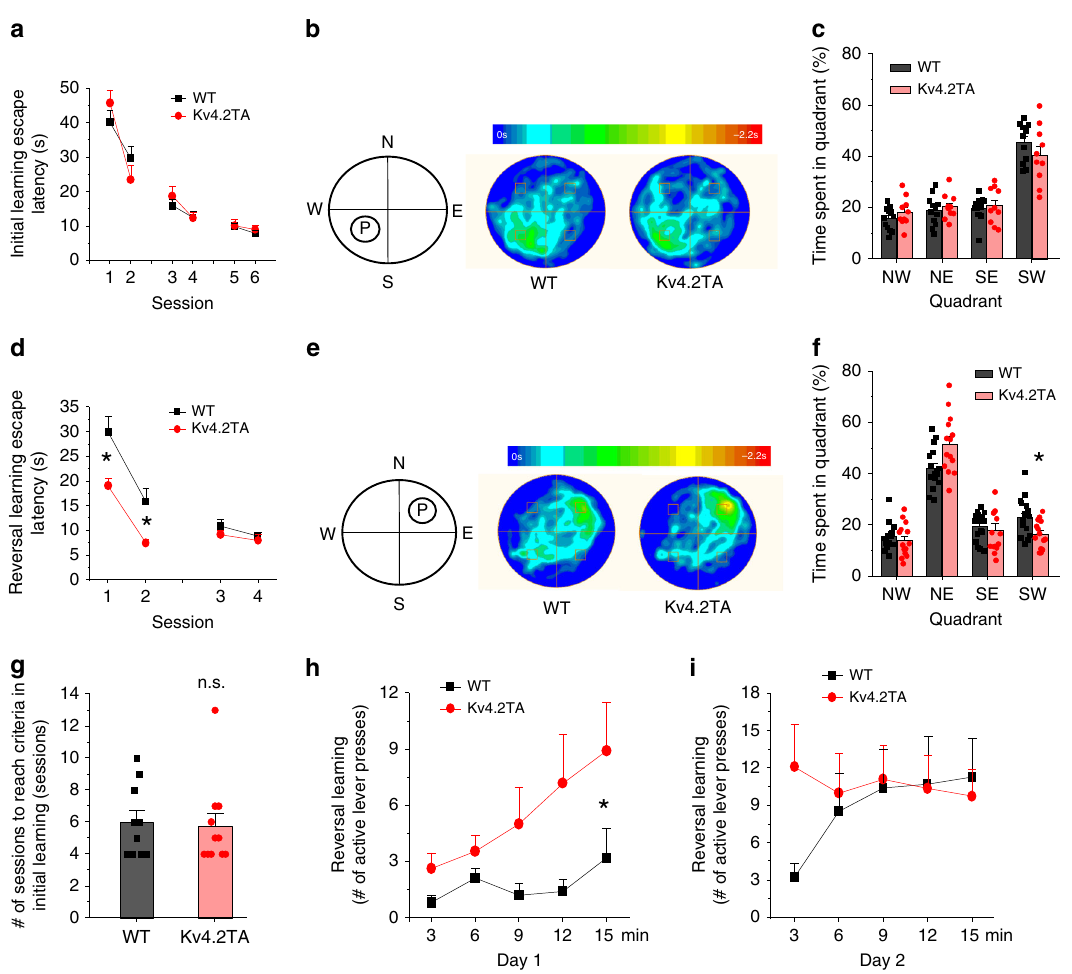
Fig. 7 Improved reversal learning in Kv4.2TA relative to WT mice. a – c Kv4.2TA mice showed normal learning of the initial platform location in the Morris water maze task. Average escape latencies of four trials per round for WT ( n = 16 mice) and Kv4.2TA mice ( n = 14 mice) over a training period of 3 days (two rounds each day). b Swimming time heat maps during the probe trial of the WT and Kv4.2TA mice at day 5. c Time spent in each quadrant during